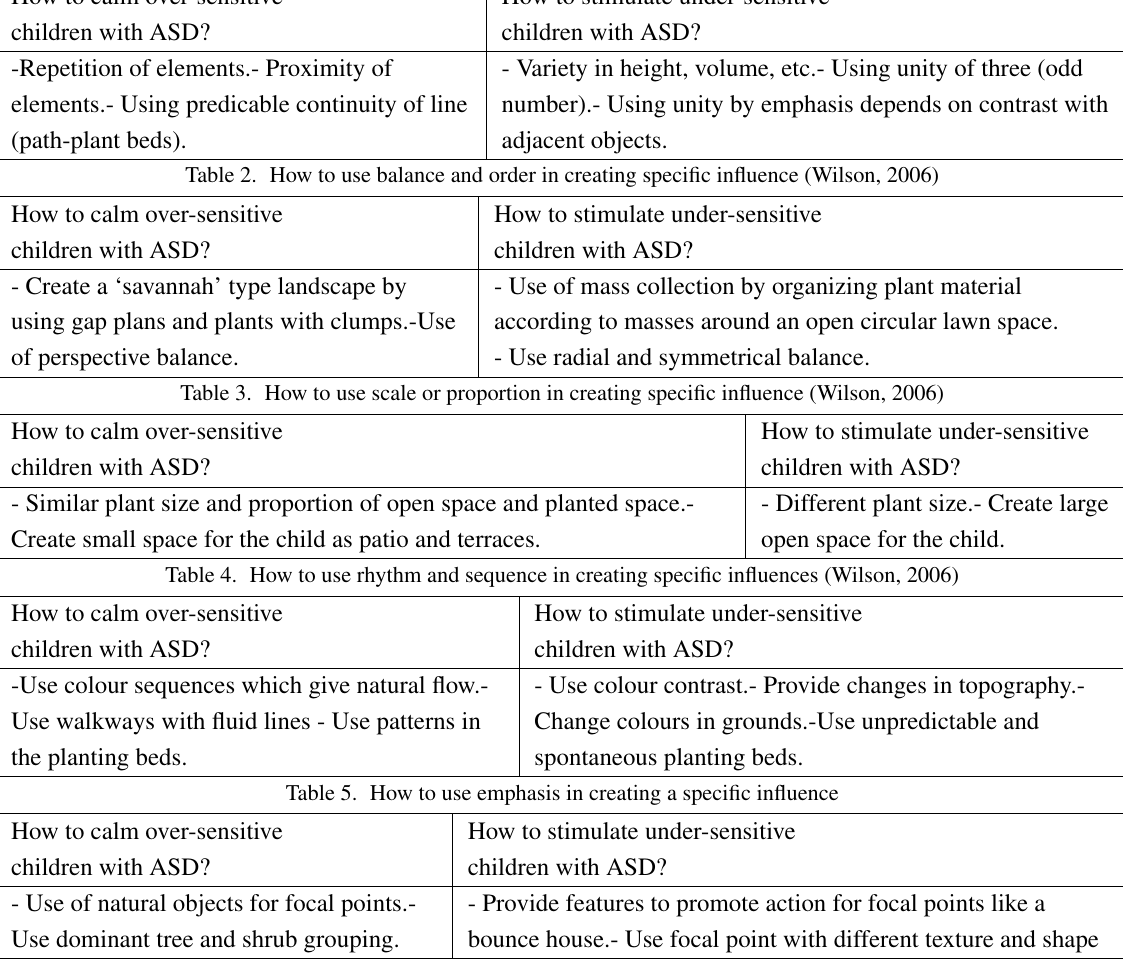
Table 1. How to use Unity and Harmony in creating a specific influence (Wilson, 2006)